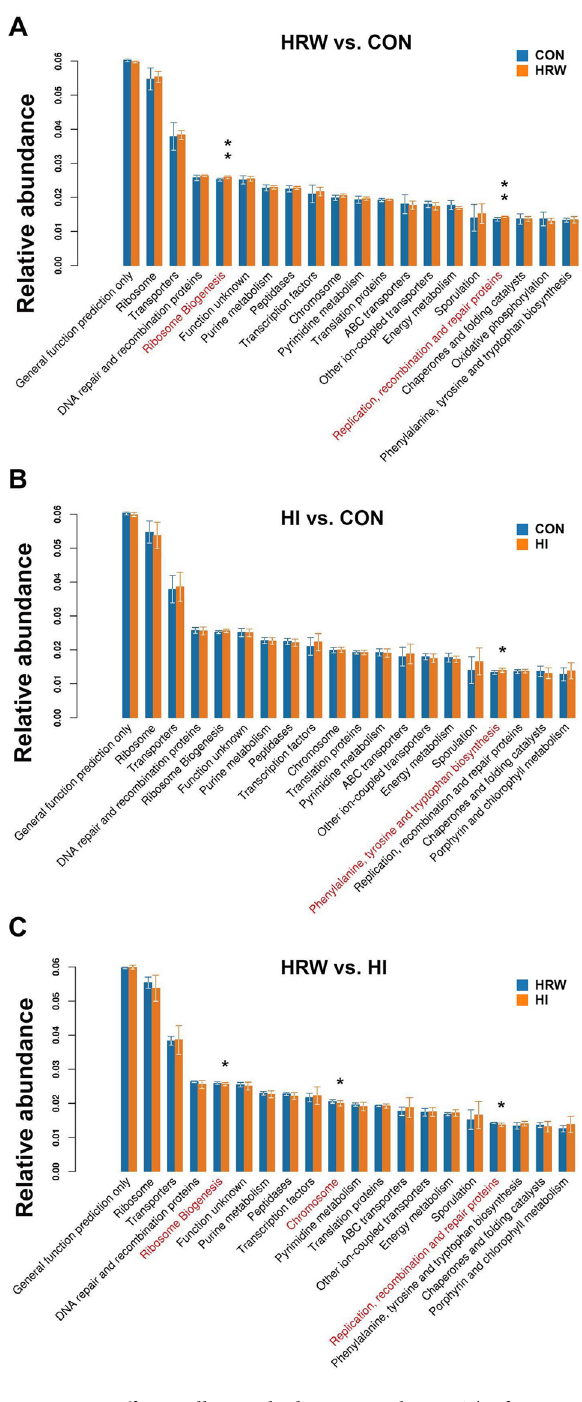
Figure 5. Differentially enriched KEGG pathways. The functional prediction at level-3 of KEGG pathway was performed by PICRUSt between HRW and Control group ( A ), HI and Control group ( B ), HRW and HI group ( C